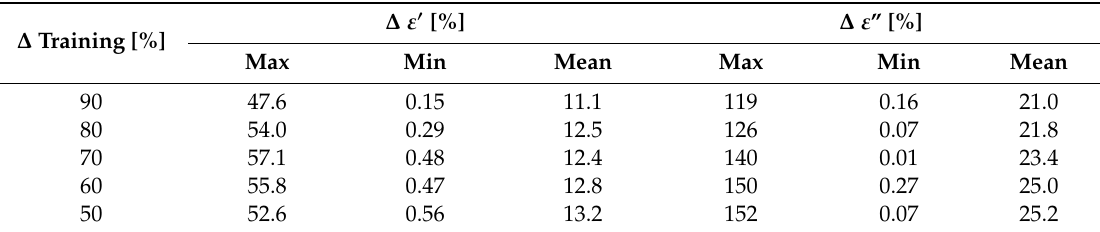
Table 5. Maximum, minimum and average di ff erences between measured and predicted permittivity at 2.45 GHz with di ff erent ratios of training to validation data ( ∆ training). Probe used: Slim Form probe; Calibration point: VNA test